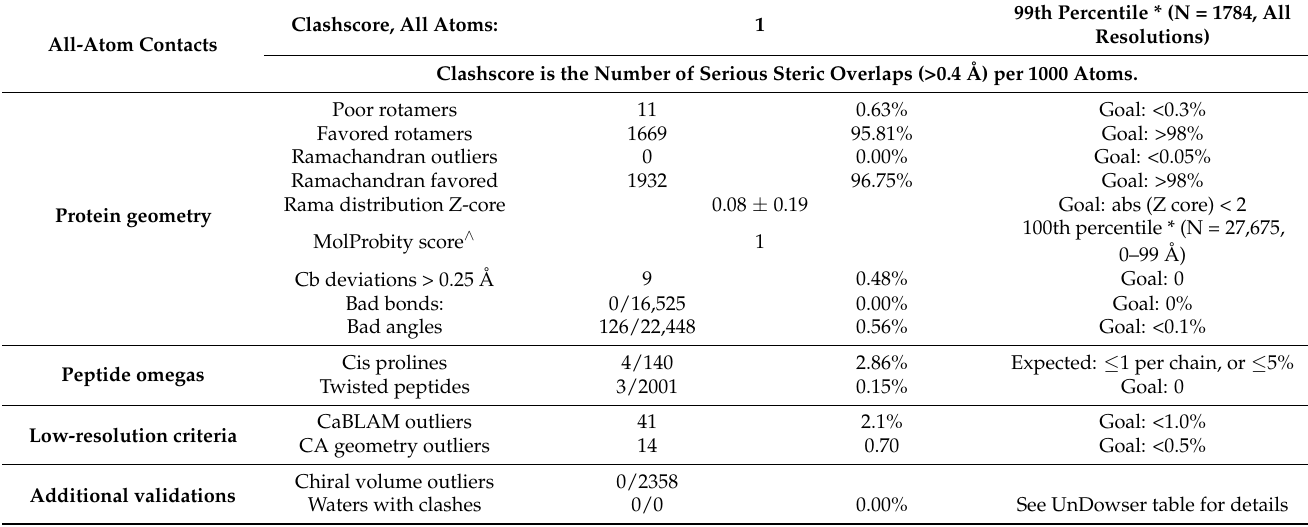
Table 1. 3D structural quality from SsCAT1.